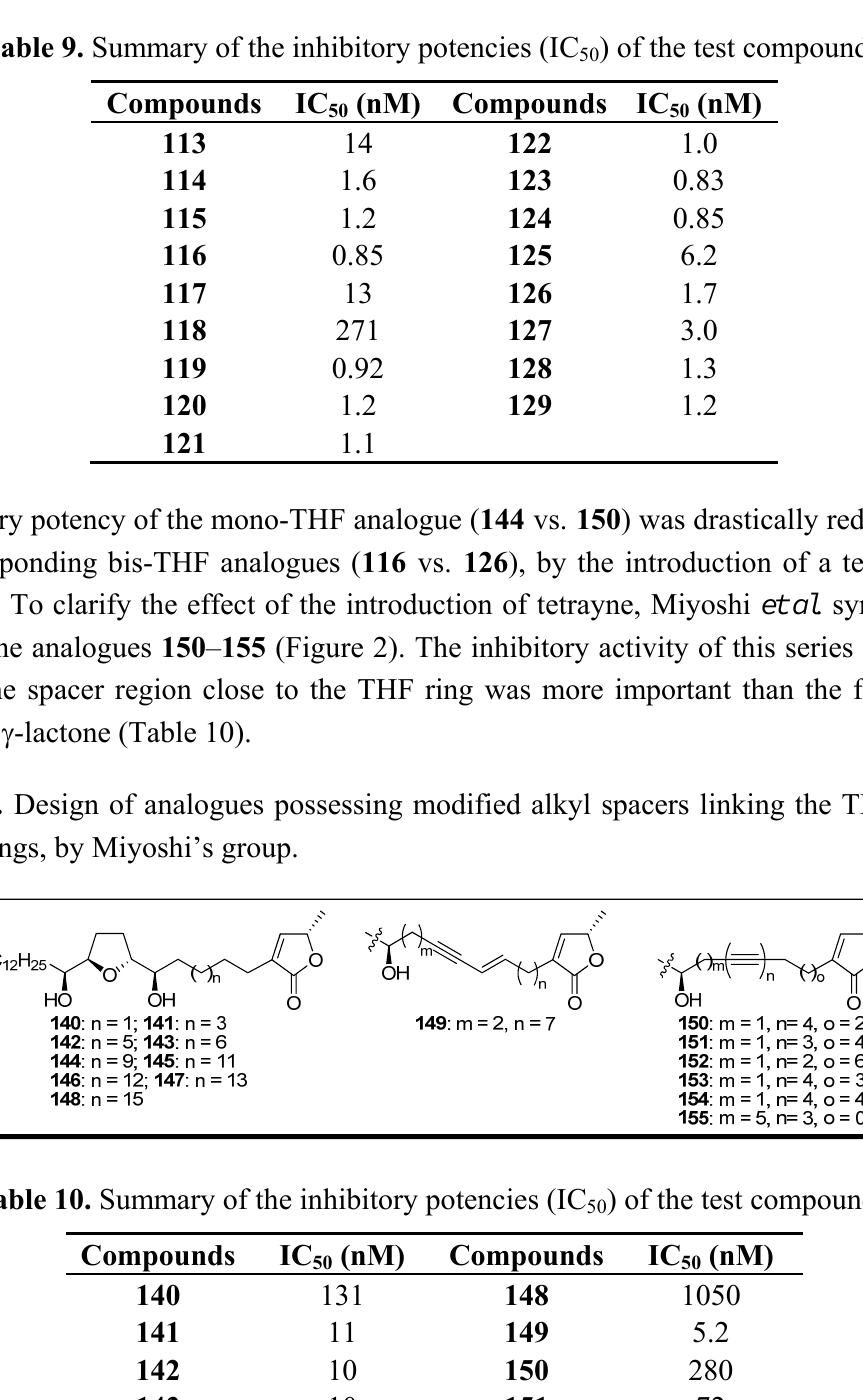
Table 9. Summary of the inhibitory potencies (IC